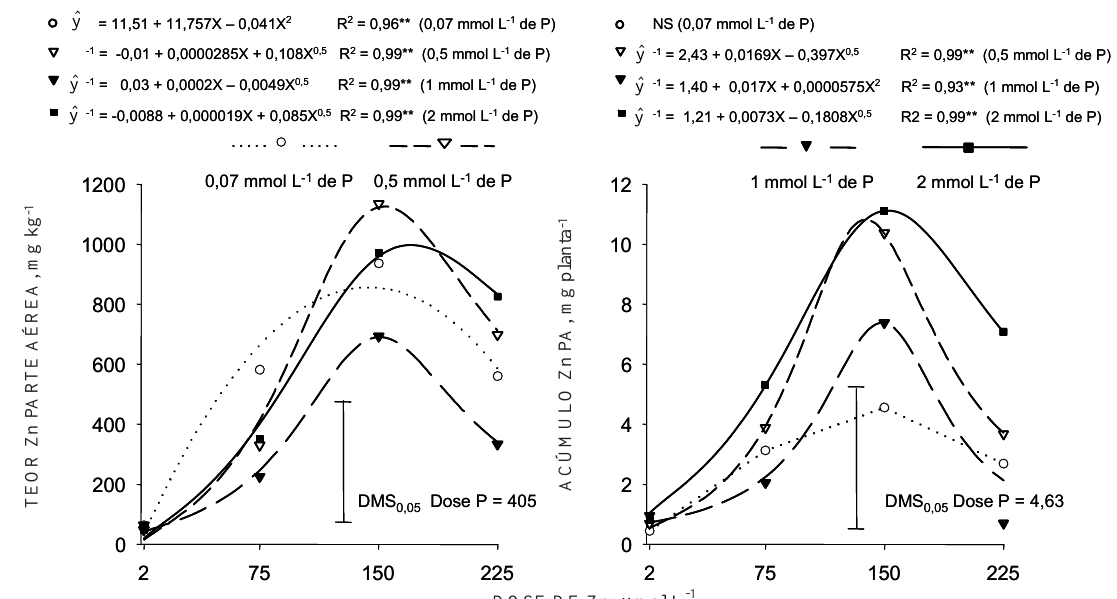
Figura 5. Teor e acúmulo de Zn na parte aérea de mudas de Trema micrantha em resposta ao aumento de doses de Zn e aplicação de P em solução nutritiva (** P <<<<< 0,01; NS = não-significativo).